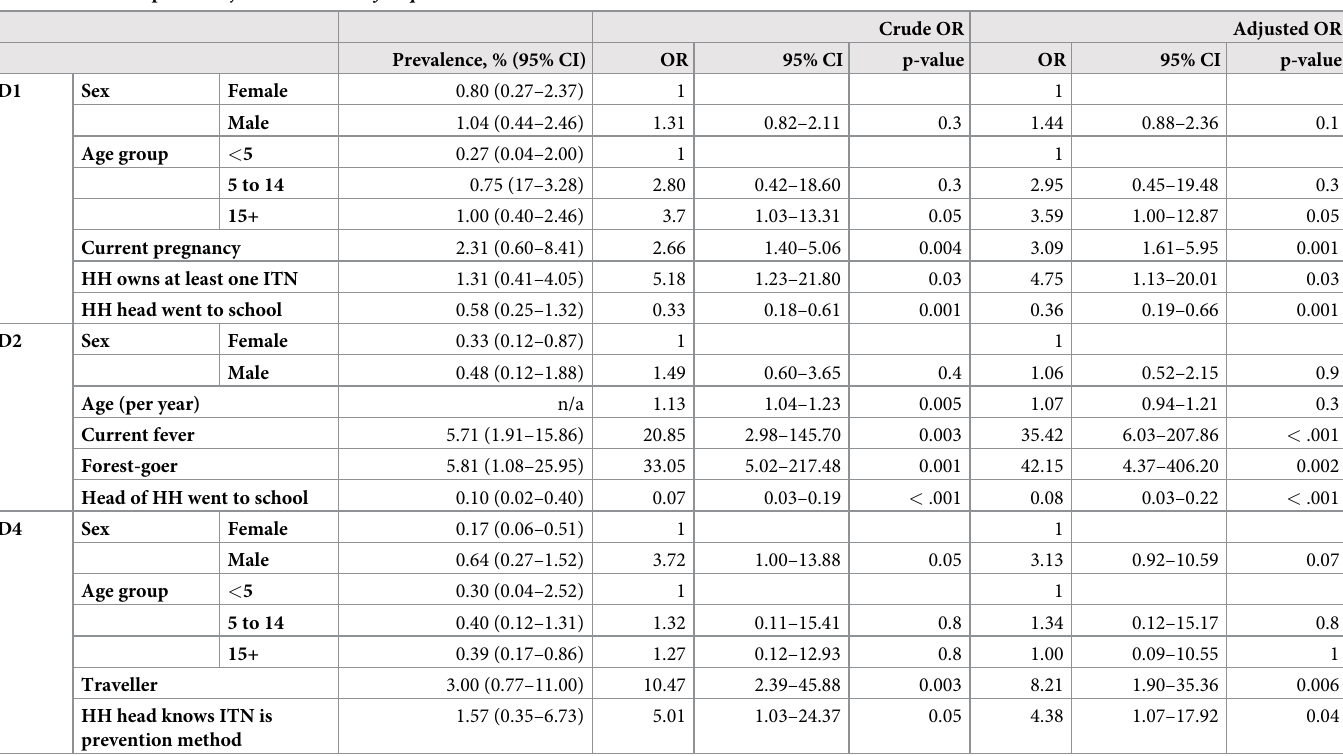
Table 2. Domain specific adjusted ORs for P . falciparum infection 1